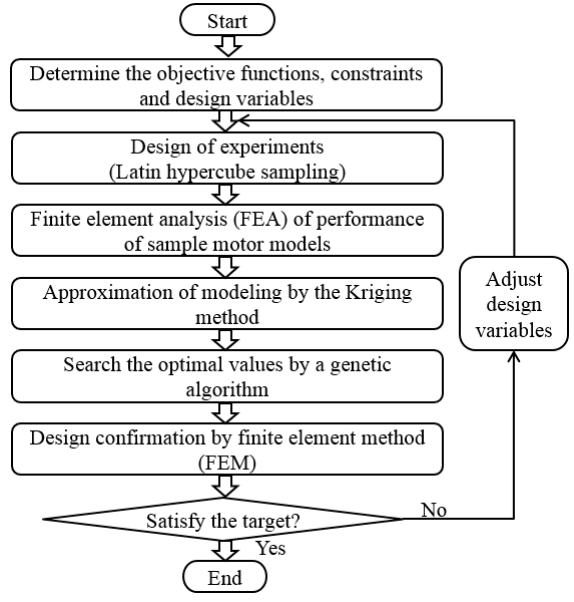
Figure 9. Optimal design process.